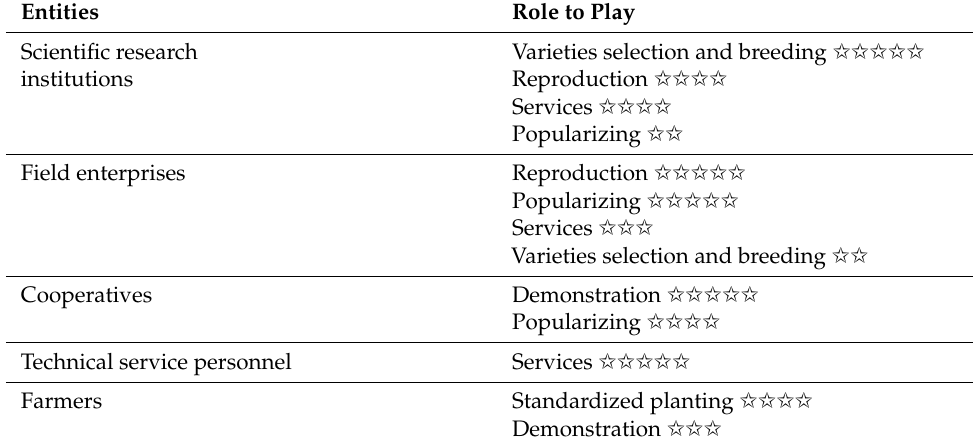
Table 5. The role of related entities in the red kidney bean